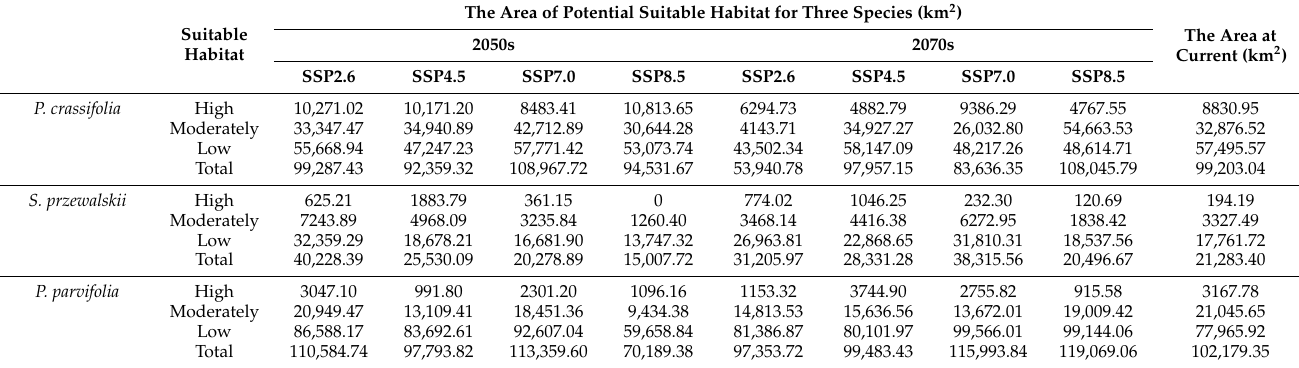
Table 3. The area of suitable habitat for three species under different climate